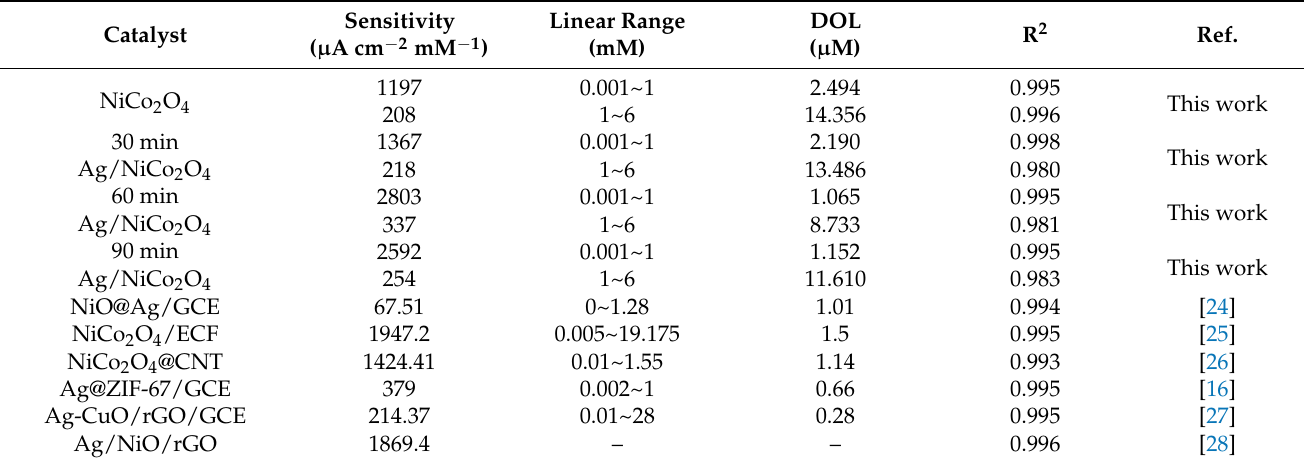
Table 1. Comparison of the key parameters of literature-reported Ag- and NiCo 2 O 4 -based glucose- sensing catalysts.